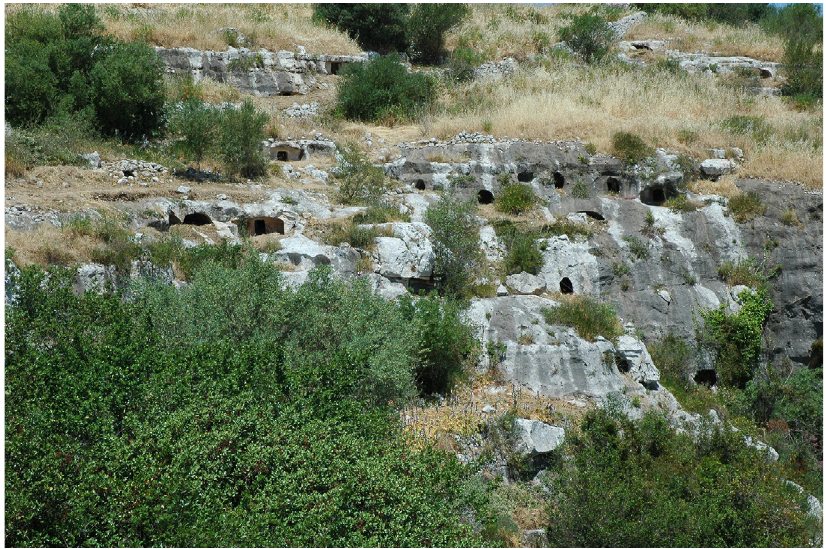
Figure 1. Calicantone. The rock-cut chamber tombs of the necropolis.